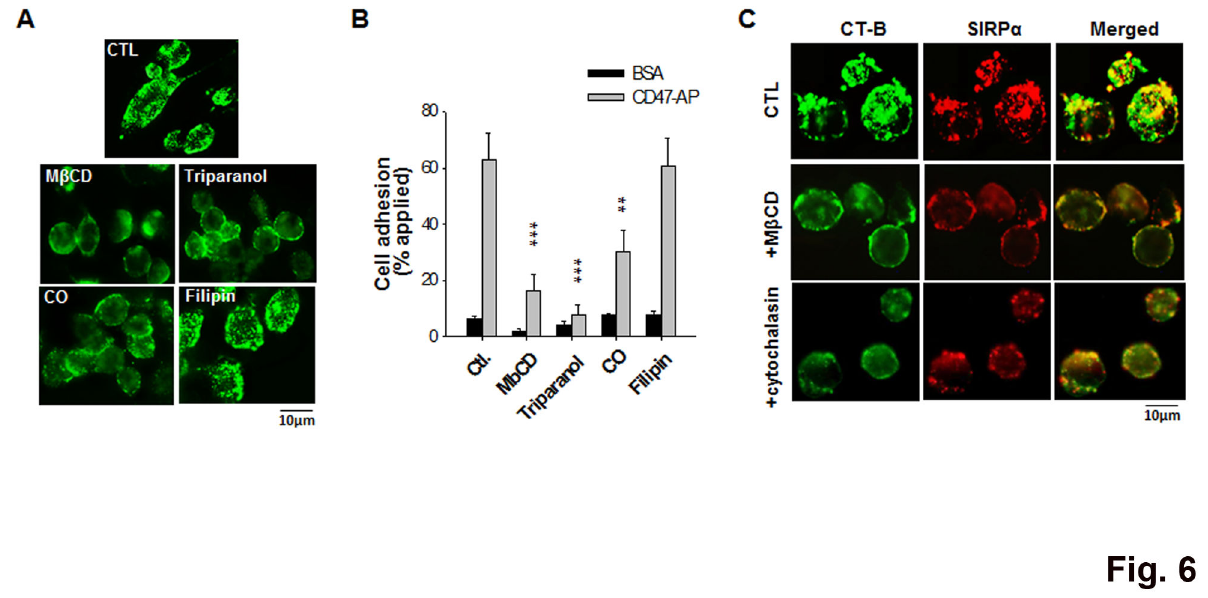
Figure 6. Clustering of SIRPα on cell surfaces requires cholesterol-rich lipid rafts. PMA-stimulated THP-1 cells were treated with lipid raft/cholesterol perturbation/modification agents, including MβCD (10 mg/ml), triparanol (5 µM), cholesterol oxidase (CO) (1 unit/ml) and filipin (0.5 µg/ml), prior to A) assessment of SIRPα on the cell surface by immunofluorescence staining, B) analysis of SIRPα localization in lipid rafts by co-staining for raft marker GM1 by cholera toxin B subunit (CT-B), C) assay of SIRPα-mediated cell adhesion to immobilized CD47-AP. **, P <0.01. ***, P <0.001. The effect of the actin filament disruption agent cytochalasin D on lipid rafts and SIRPα distribution was also tested (shown in